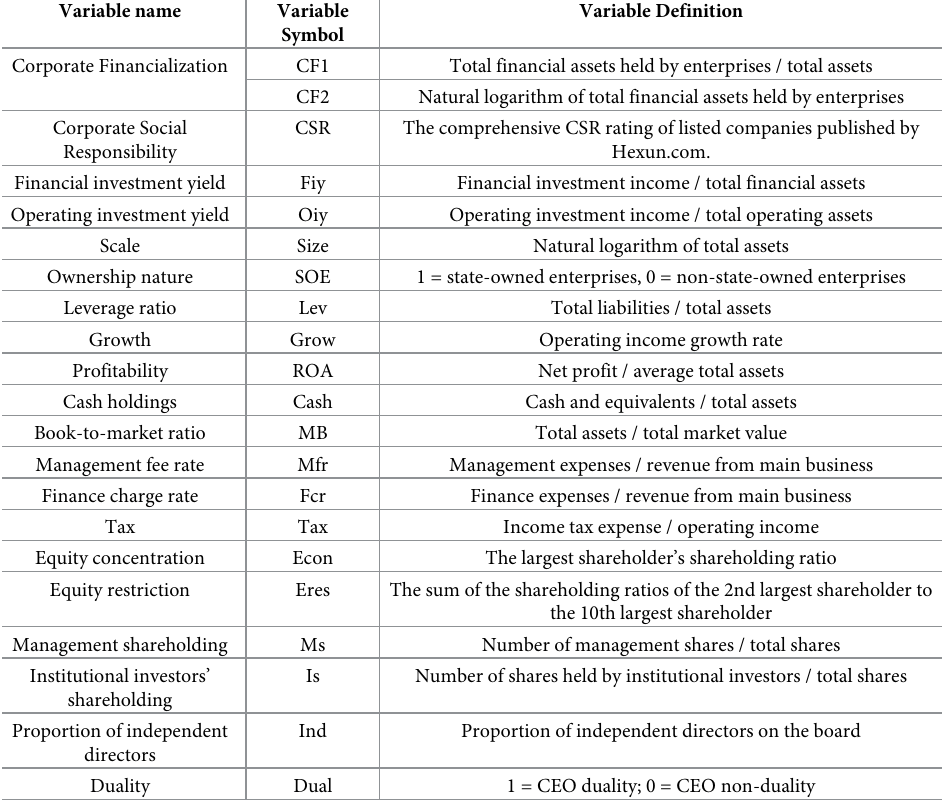
Table 1. Definition of